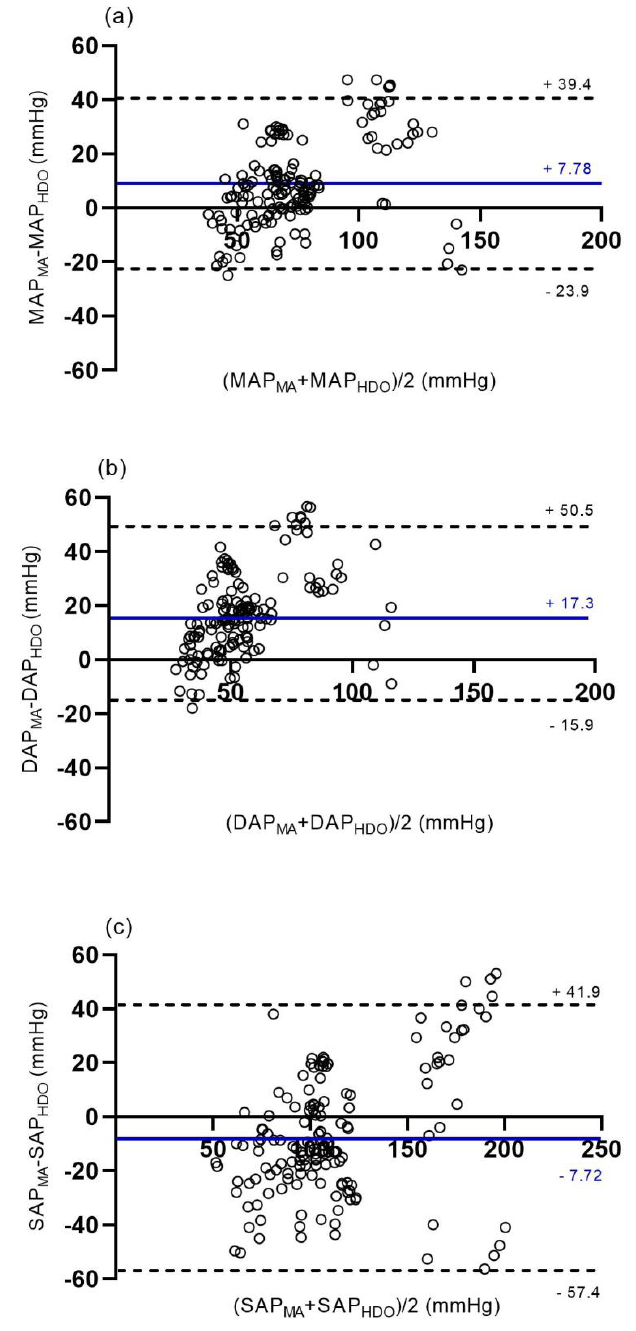
Figure 3. Bland–Altman plots for ( a ) mean arterial pressure (MAP), ( b ) diastolic arterial pressure (DAP), and ( c ) systolic arterial pressure (SAP) measured by invasive (IBP) technique at the metatarsal artery (MA) and non-invasive (NIBP) technique by high-definition oscillometry (HDO) at the contralateral MA in 11 isoflurane anaesthetised and dorsally recumbent horses at different blood pressure ranges (normotension: MAP 61–119 mmHg; hypotension: MAP ≤ 60 mmHg; hypertension: MAP ≥ 120 mmHg). A total of 152 paired measurements are depicted. The blue horizontal line represents mean bias, and the dashed black lines the upper and lower limits of agreement (LOA), respectively. On the x-axis, the average, and on the y-axis, the difference between the two measure- ments is shown. A positive bias reflects underestimation, and a negative bias reflects overestimation of IBP by